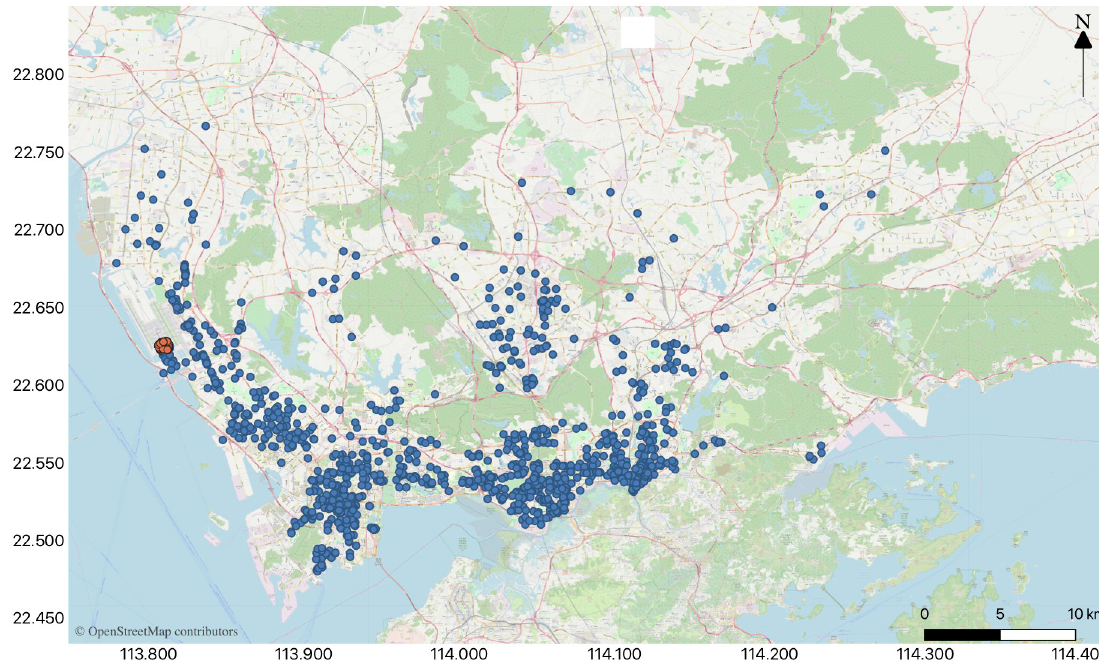
Fig 3. Visualization of the order demand on 10 August, 2015 (orders to Shenzhen